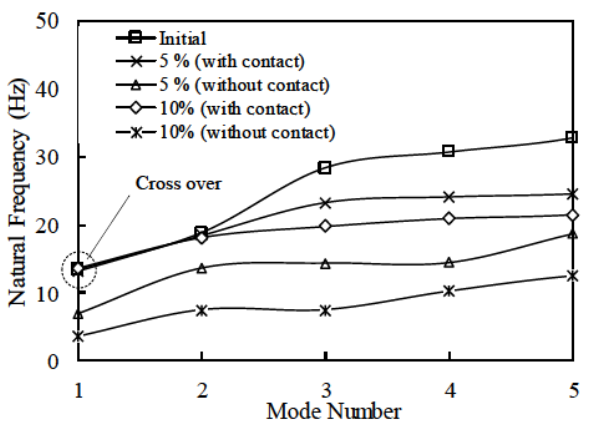
Figure 5: Numerical eigenfrequencies as a function of mode shape of models